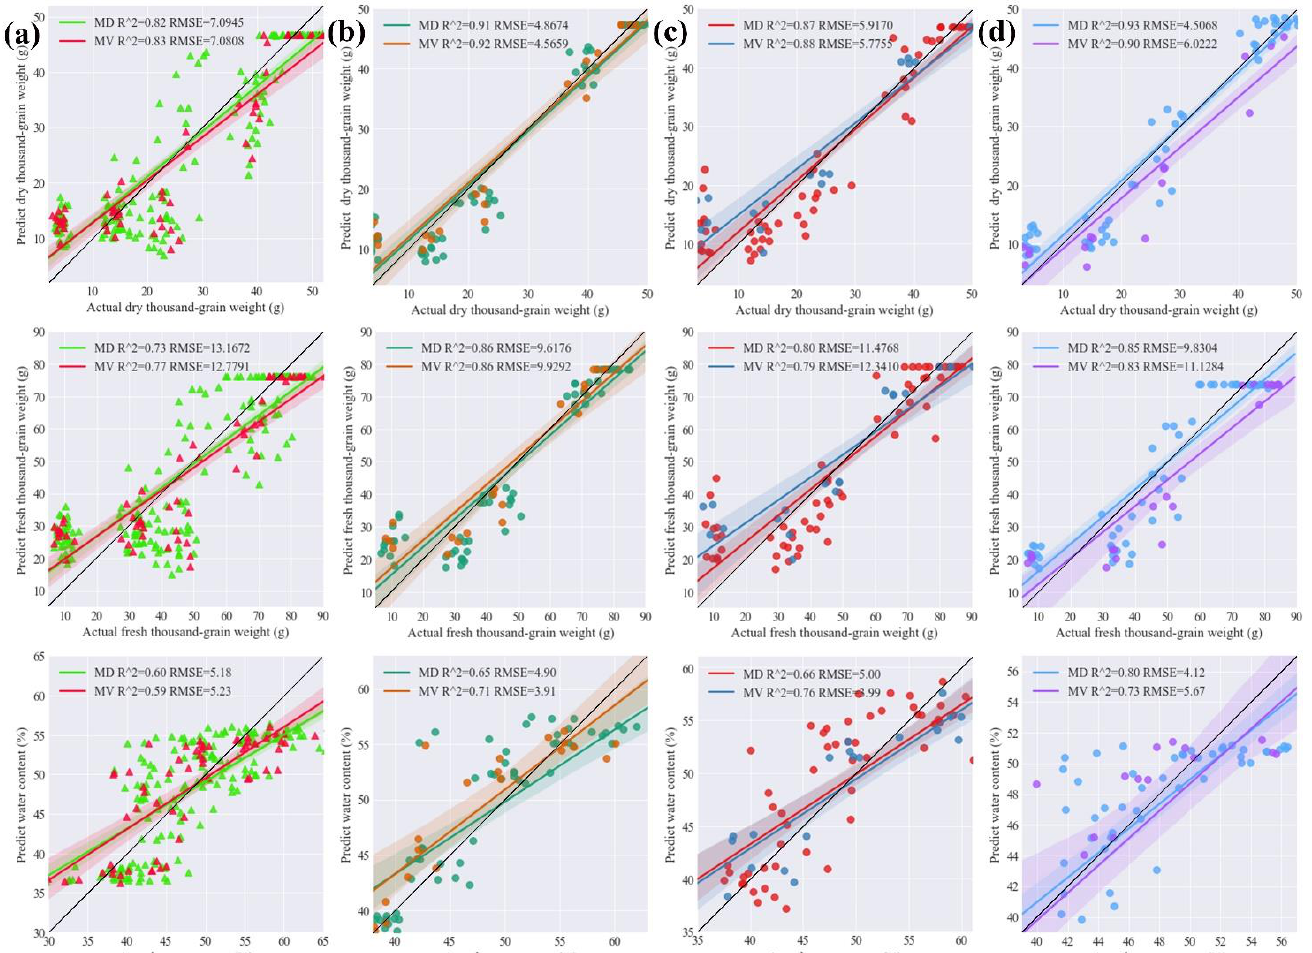
Figure 7. Reliability testing of the remote sensing monitoring model of three indicators of winter wheat in the grain-filling stage. ( a ) is the overall model, and ( b – d ) are the single-cultivar models of Xumai 44, Xumai 43 and Xumai 33, respectively.